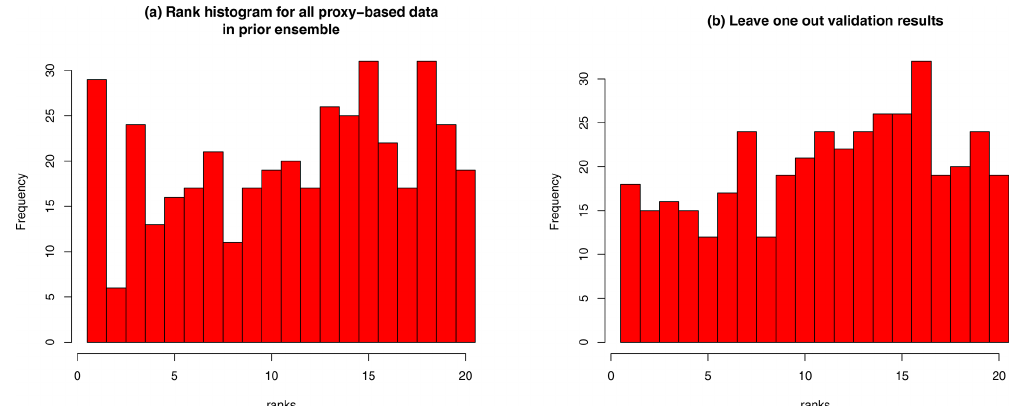
Figure 3. (a) Rank histogram of proxy data in prior ensemble, showing the position of each data point in the ordered set of model values. (b) Rank histogram of withheld proxy data in posterior ensemble in leave-one-out validation